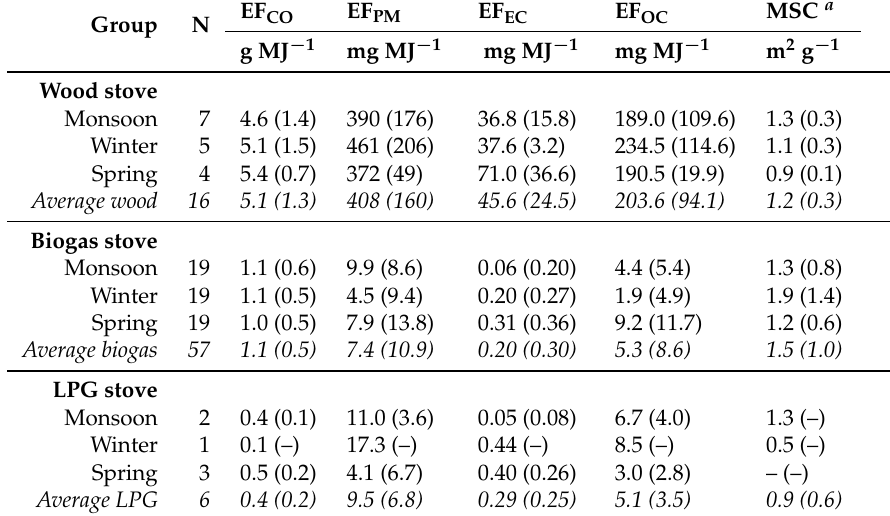
Table 1. Average and standard deviation of emission factors and emission metrics separated by fuel and season, analyzed at the event level.